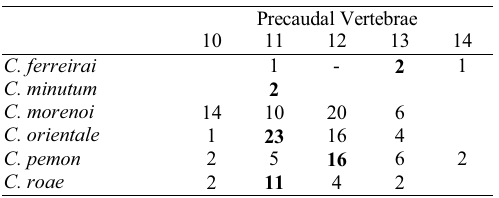
Table 6. Number of species of the specimens of Cetopsidium with cited number of precaudal vertebrae. Bold indicates values for holotype when examined.